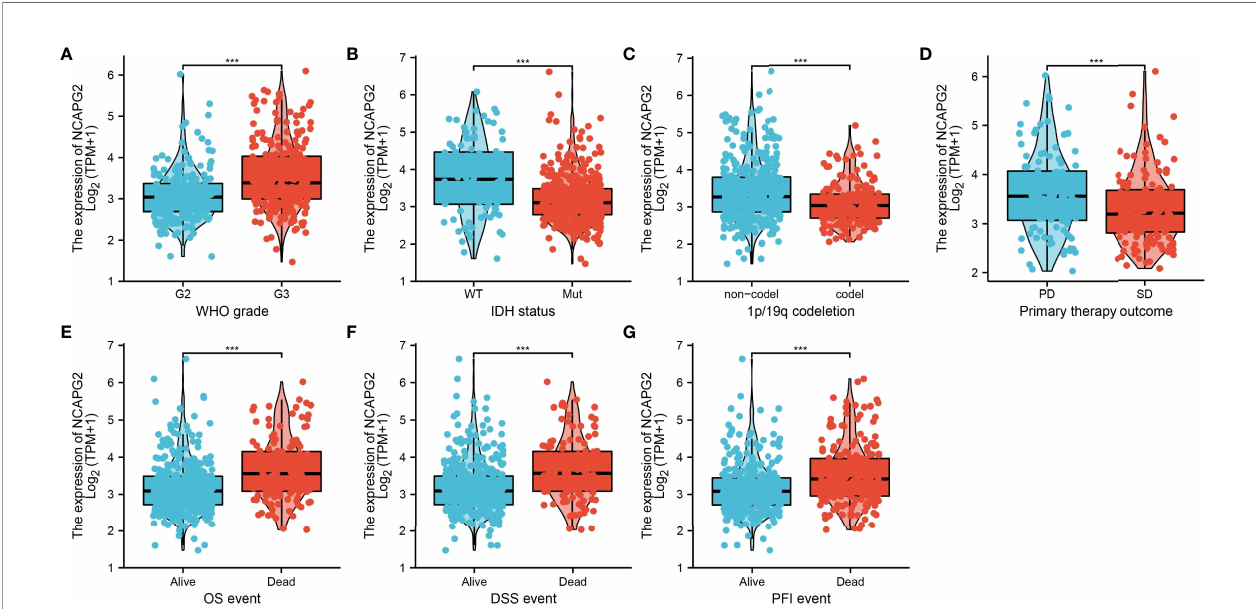
FIGURE 2 | The correlation between NCAPG2 expression and clinical information in LGG. (A – G) The correlation between NCAPG2 expression and clinical features, including the higher tumor grades, IDH mutation status, 1p/19q chromosome co-deletion, primary therapy outcome, OS event, DSS event, and PFS event. P < 0.001